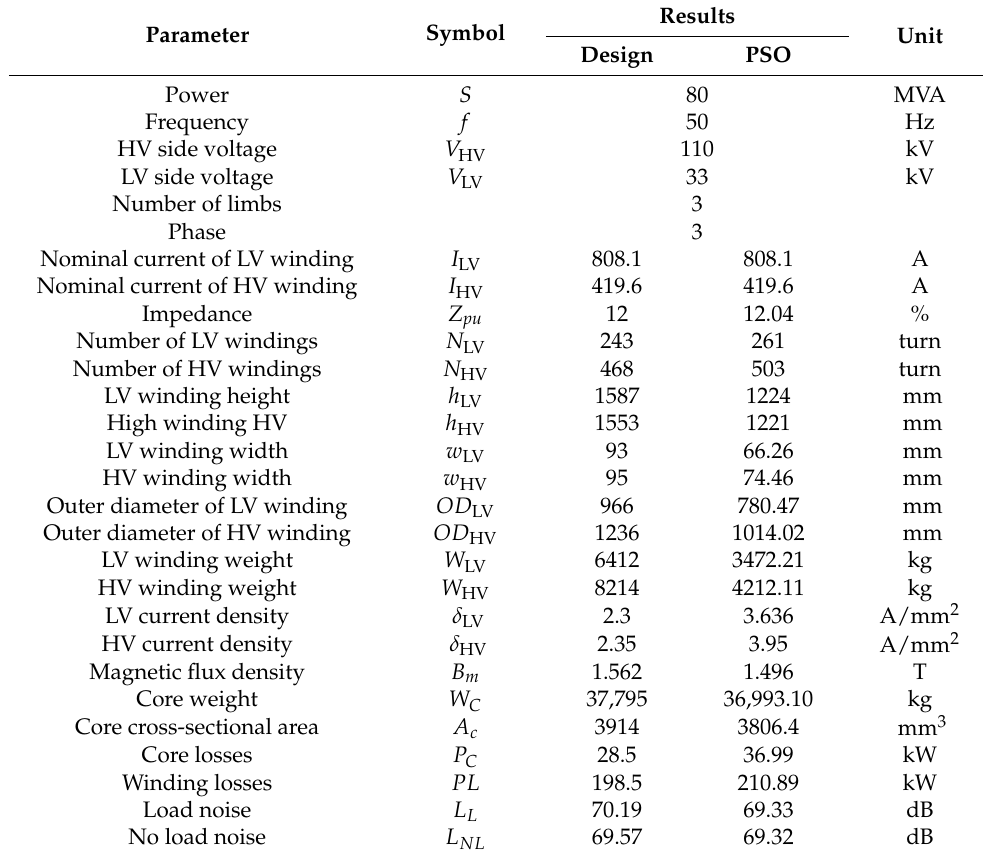
Table 6. Comparison of the results of design and optimization parameters with